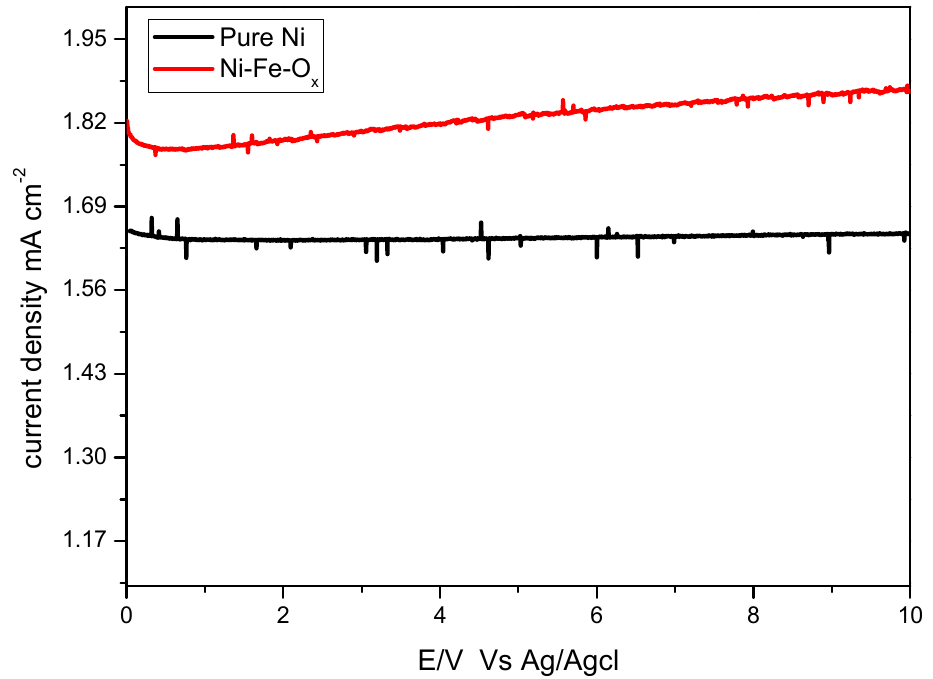
Figure 4. Chrono-potentiometric test of Ni–Fe–O x alloy as an OER electrocatalyst at 1.6 V vs. RHE in 1 M KOH.